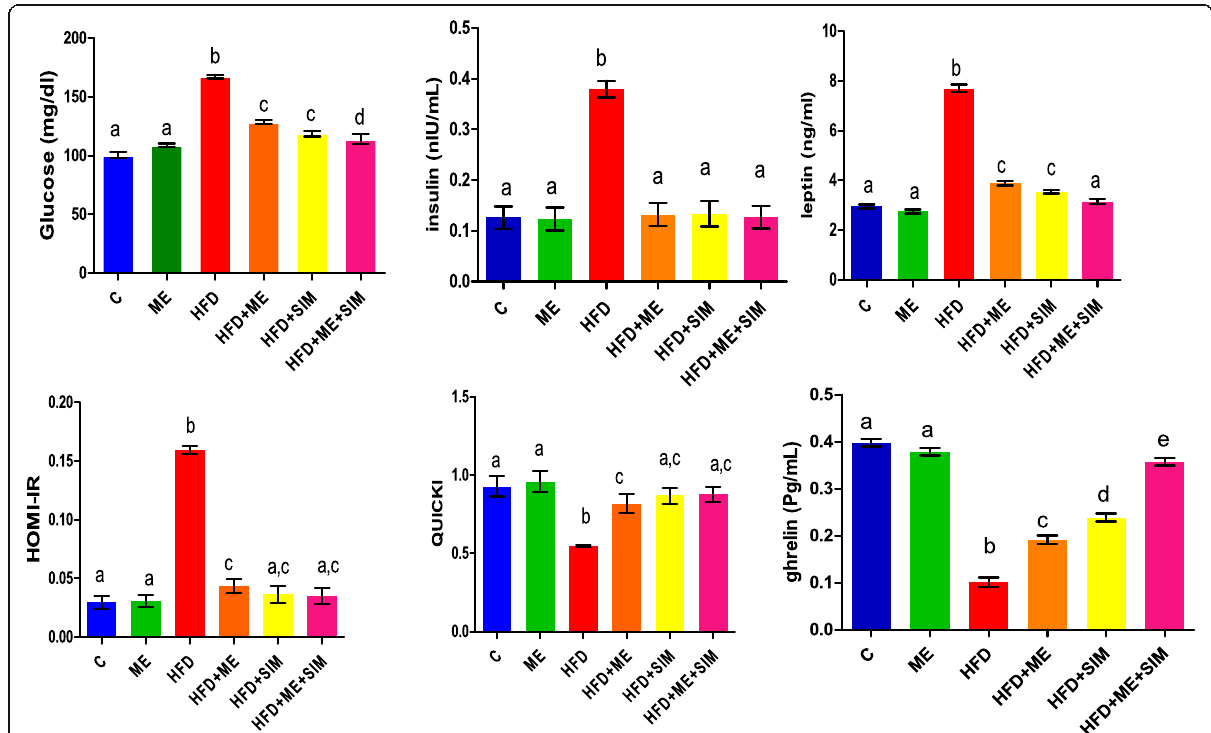
Fig. 2 The effects of Moringa leaf extract (ME), simvastatin (SIM) and their combination (ME+SIM) on serum glucose, insulin, leptin, gherlin, homeostasis model assessment for insulin resistance (HOMA-IR) and quantitative insulin sensitivity check index (QUICKI) in rats fed a high-fat diet (HFD) for 6 weeks. ME prevented the increase in serum levels of glucose metabolic hormones (leptin and gherlin), decreased insulin levels and improved HOMA-IR and QUICKI, which indicates amelioration of insulin tissue resistance. Different letters indicate significant differences between groups ( p < 0.05). Values are means ±SD ( n = 6)